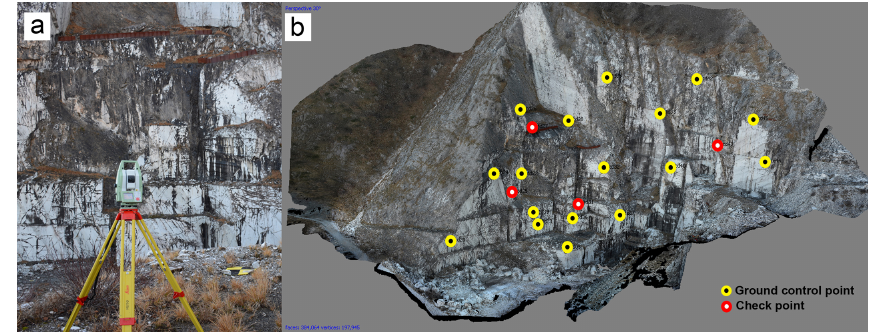
Figure 6. Topographic survey with TS (a) and spatial distribution of GCPs and check points for the RPAS frontal flights (b) .